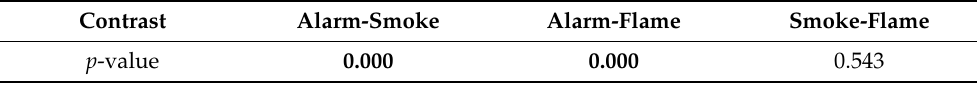
Table 8. p -values of pupil